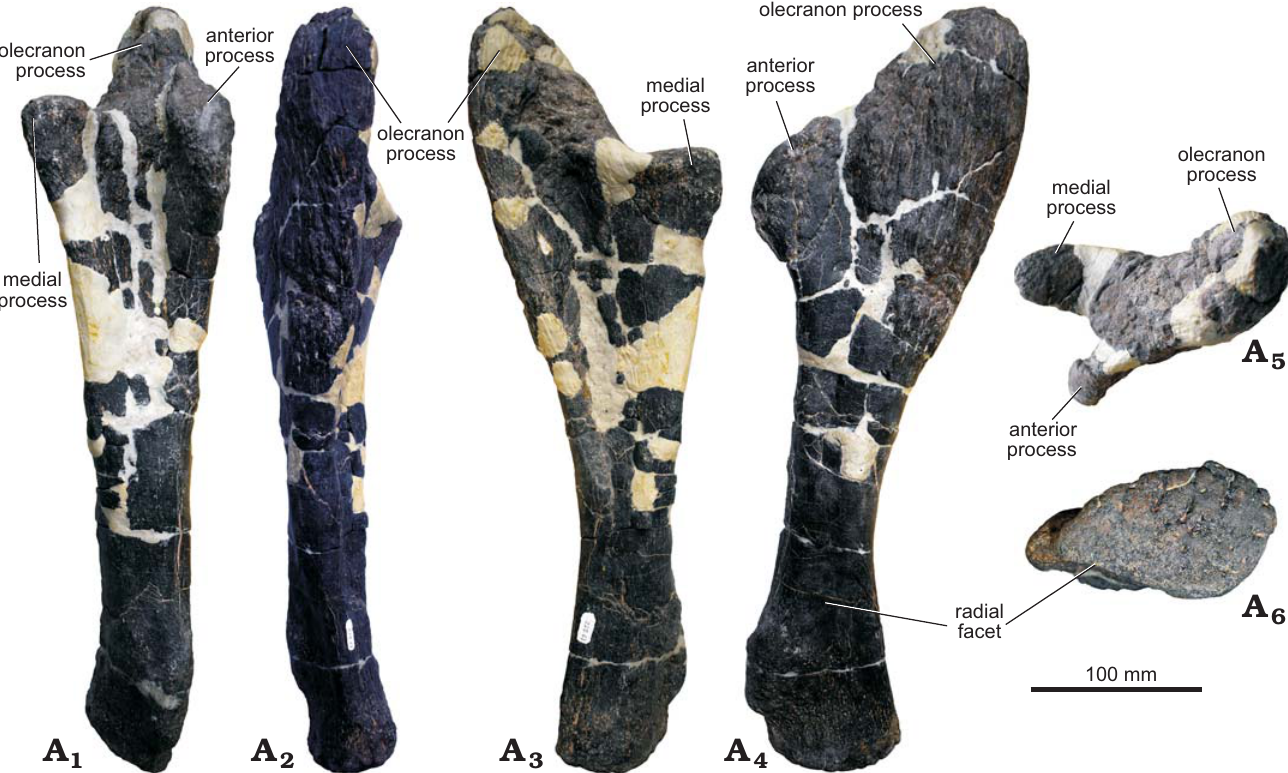
Fig. 3. Left humerus of stegosaur GPDM 205 from the 5E Ranch, Little Snowy Mountains, Fergus County, Montana, USA; in anterior (A 1 ), posterior (A 2 ), lateral (A 3 ), medial (A 4 ), dorsal (A 5 ), and ventral (A 6 ) views.